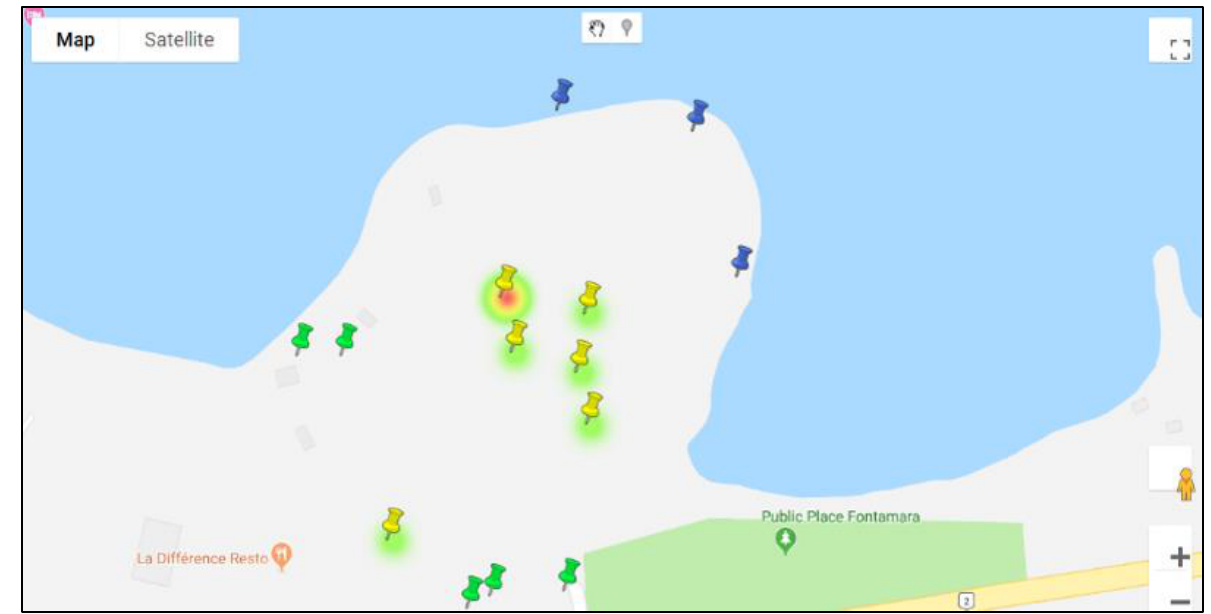
Figure 10. Heatmap for M neighborhood for July 2017. The water point with the highest intensity is M13. The water point south of M13 (nearest) is M1.